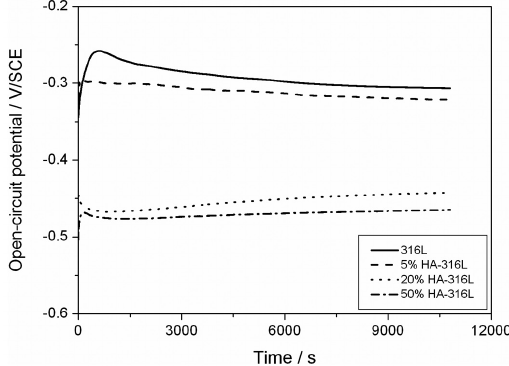
Figure 5. Variation of open-circuit potential with time for sintered 316L stainless steel and HA‑316L composites in 0.1M HCl solution at room temperature.